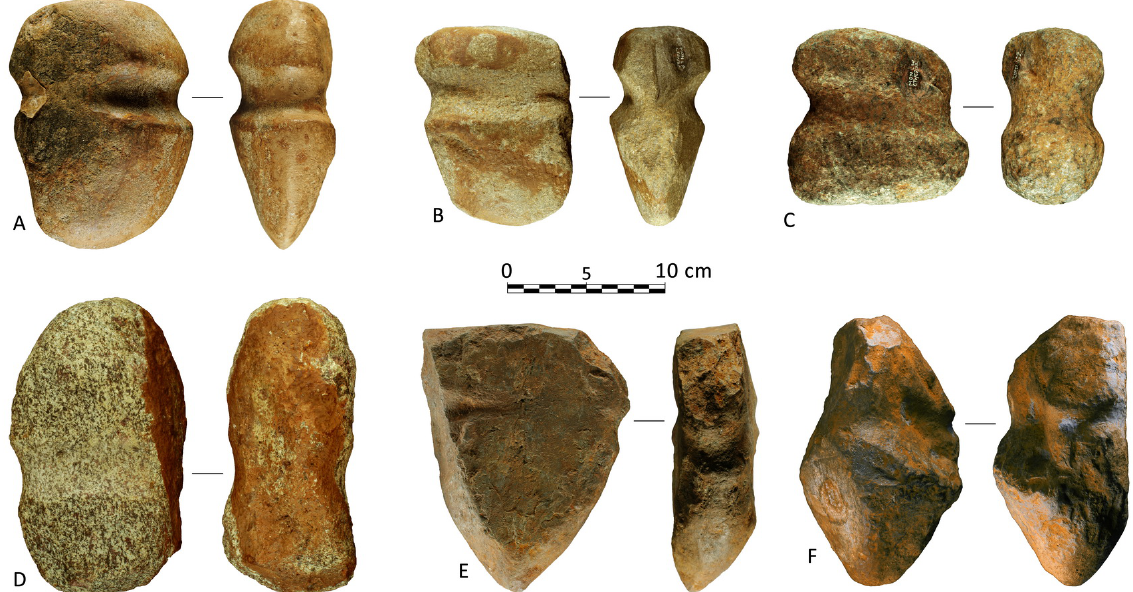
Figure 4. Grooved stone tools from the underground site of Grotta della Monaca (Sant'Agata di Esaro, Cosenza): A-B. hammer-axes, L1 / L7; C-D . hammers, L10 / L8; E-F. pickaxes, L222 / L34 (pictures by F.